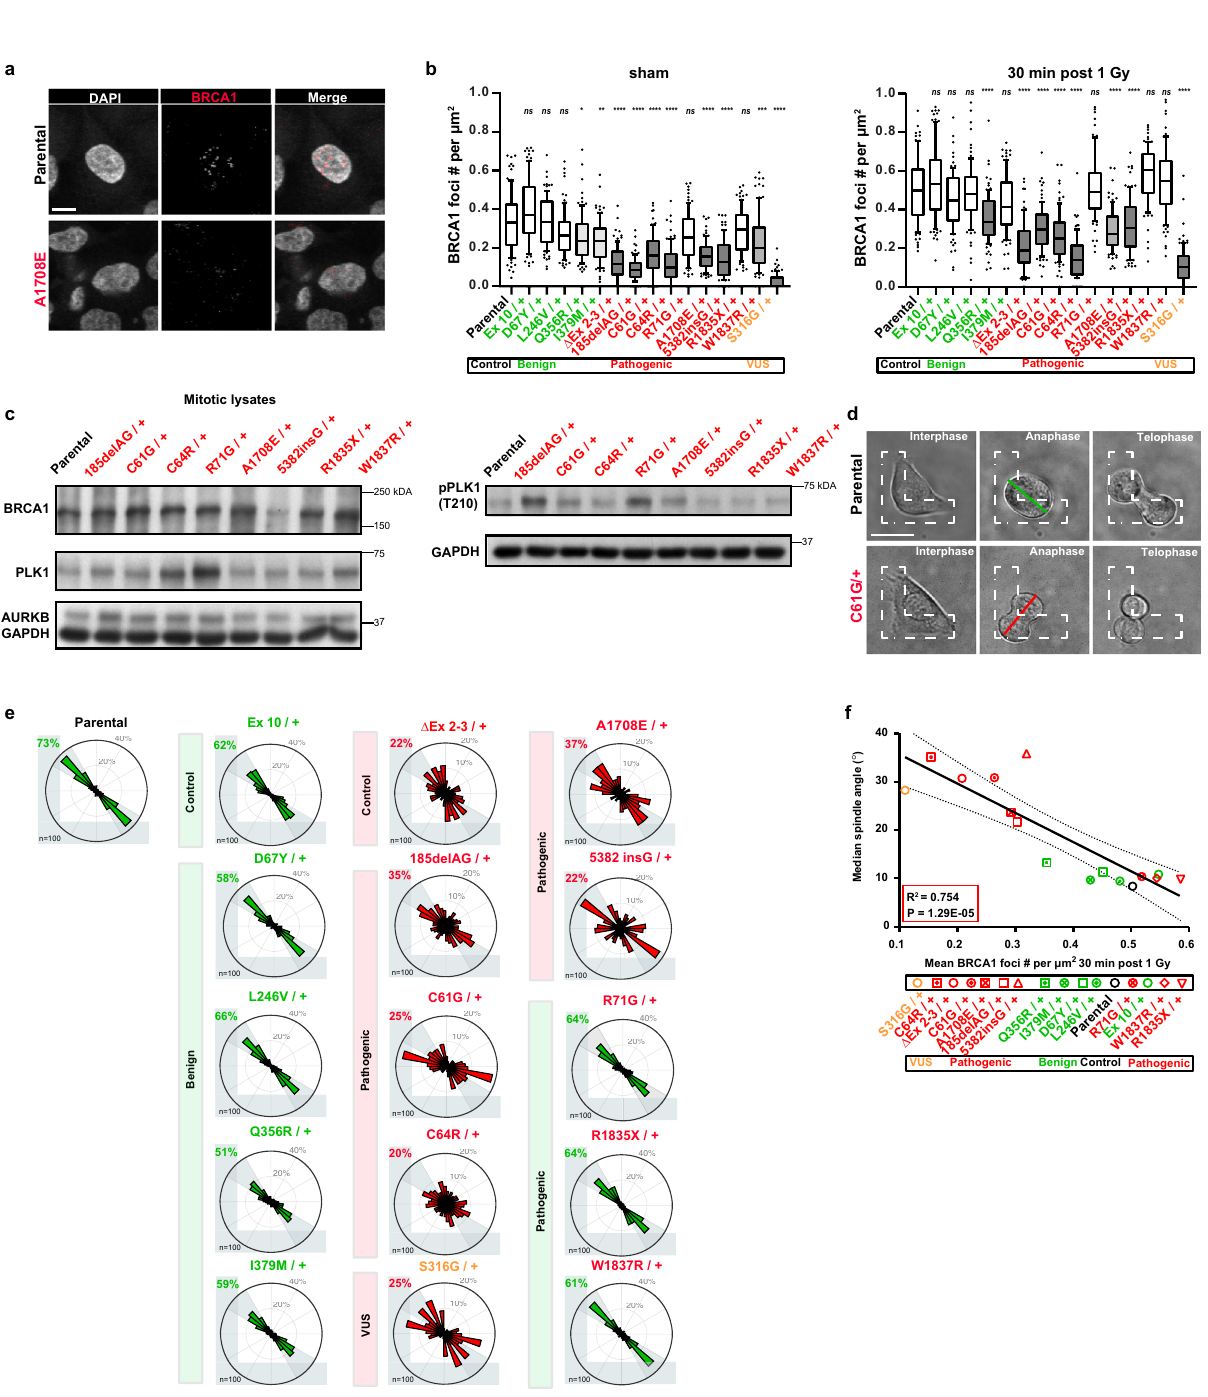
Fig. 2 Mammary progenitor cells from BRCA1 mutation carriers display an elevated mitotic rate, but do not orient cell divisions. a Colonies formed after 8 days per 500 cells seeded for BCs and LPs isolated from premenopausal non-carrier donors (N1, N2, and N3) or BRCA1 mutation carriers (B1, B2, and B3). Prior to seeding, cells were sham-treated or X-radiated with 1 Gy (mean ± SD, triplicate experiment values shown). ns P = 0.9851, * P = 0.0225, ns P = 0.6867, **** P = 1.73E − 05; two-tailed unpaired t -test. b Individual LPs or BCs from a premenopausal non-carrier donor (N1) or a BRCA1 mutation carrier (B1) seeded on fi bronectin-coated, L-shaped micropatterns and imaged during cell division to determine the orientation of cell division at anaphase indicated by a line connecting the spindle poles. Scale bars = 20 μ m. c Percentage of adherent cells that underwent mitosis in a 24-h period following seeding on L-shaped micropatterns (mean ± SD, fi eld of view values shown, three fi elds per experiment, triplicate experiments). Data is presented for BCs and LPs isolated from premenopausal non-carrier donors (N1, N2, and N3) or BRCA1 mutation carriers (B1, B2, and B3). Representative images are provided in Supplementary Figure 3a. **** P < 1E − 15, *** P = 0.0006; two-tailed unpaired t -test. d Distribution of cell division angles measured at anaphase in 10°- wide sectors for BCs and LPs isolated from premenopausal non-carrier donors and BRCA1 mutation carriers. Data is pooled for three patient samples per genotype (each patient has n = 50 cells per experiment, duplicate experiments). Distribution of cell division angles for individual samples is provided in Supplementary Figure S3c. Gray percentages indicate the percent of total mitotic cells